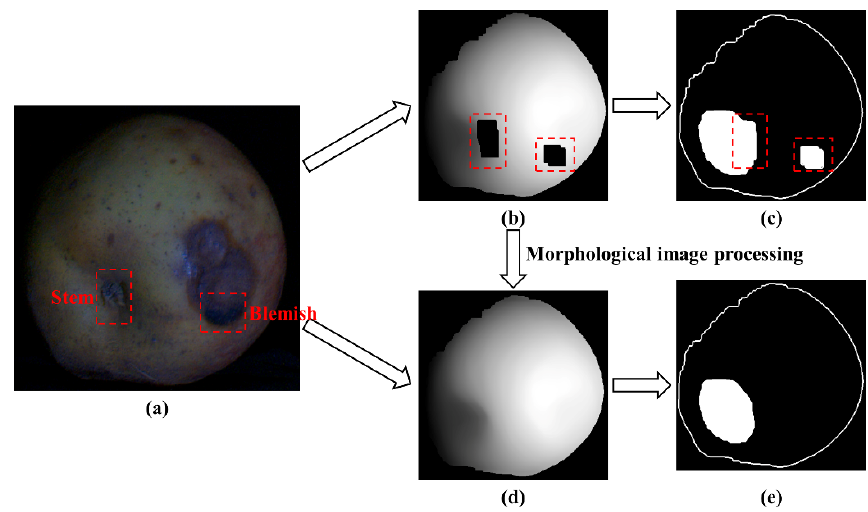
Figure 8. Identification results when the surface contains shadows. ( a ) Image of an apple; ( b ) 3D reconstruction with shadows; ( c ) identification results when the surface contains shadows; ( d ) 3D reconstruction result after morphological image processing; ( e ) identification result after morphological image processing.